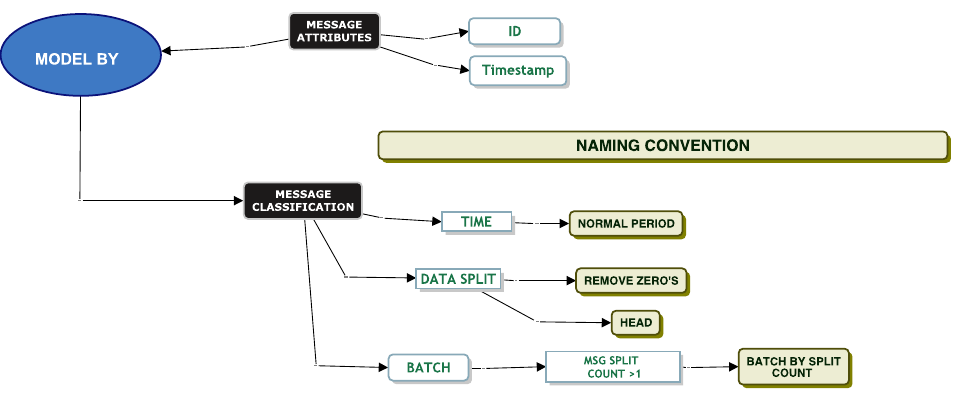
Figure 15. Batch by split count, classification model.